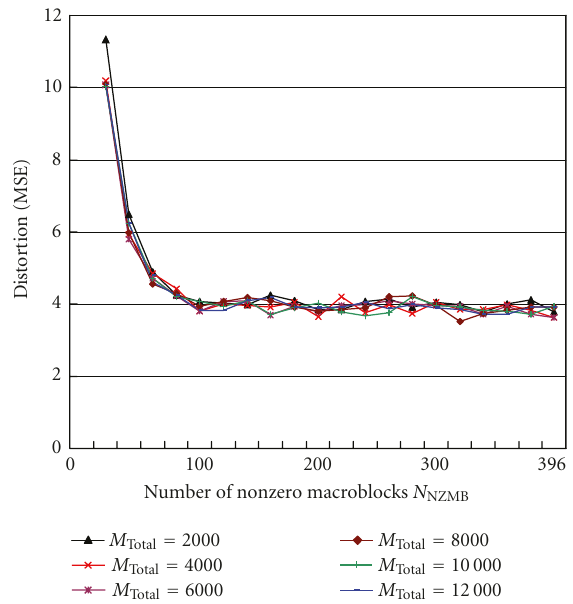
Figure 4: The distortions of the Football sequence for di ff erent numbers of nonzero macroblocks ( N NZMB ) and SAD operations ( M Total ).